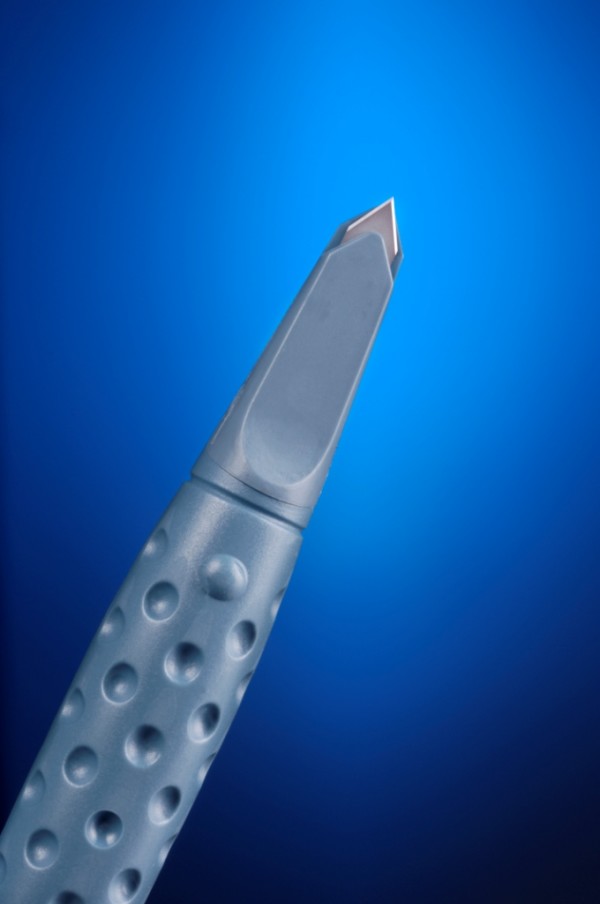
BD Beaver™ Accurate Depth knife.